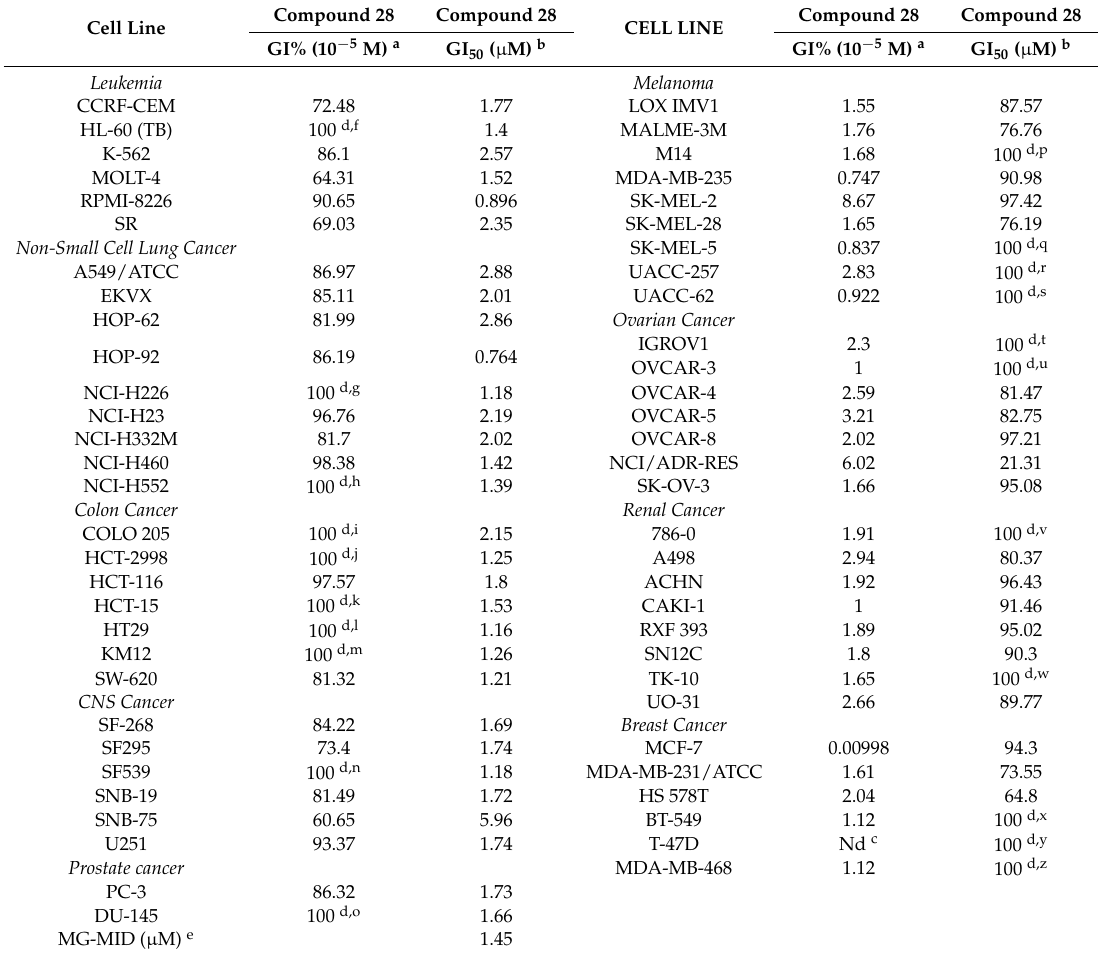
Table 5. Results of the in vitro human cancer cell growth inhibition for compound 28 a . Antiproliferative evaluation of compound 28 in the NCI60 cell line in vitro